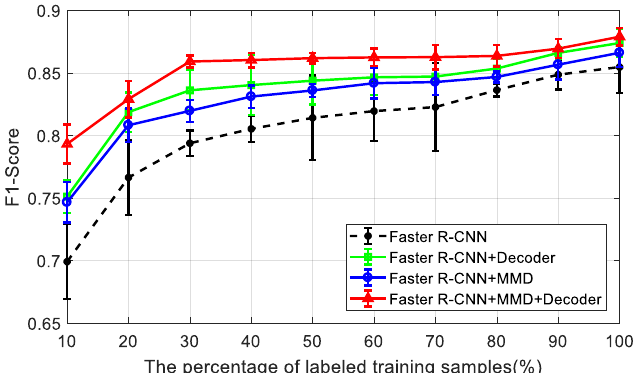
Figure 6. The ablation study results of the F1-scores for our method with different percentages of labeled training samples on the miniSAR dataset.